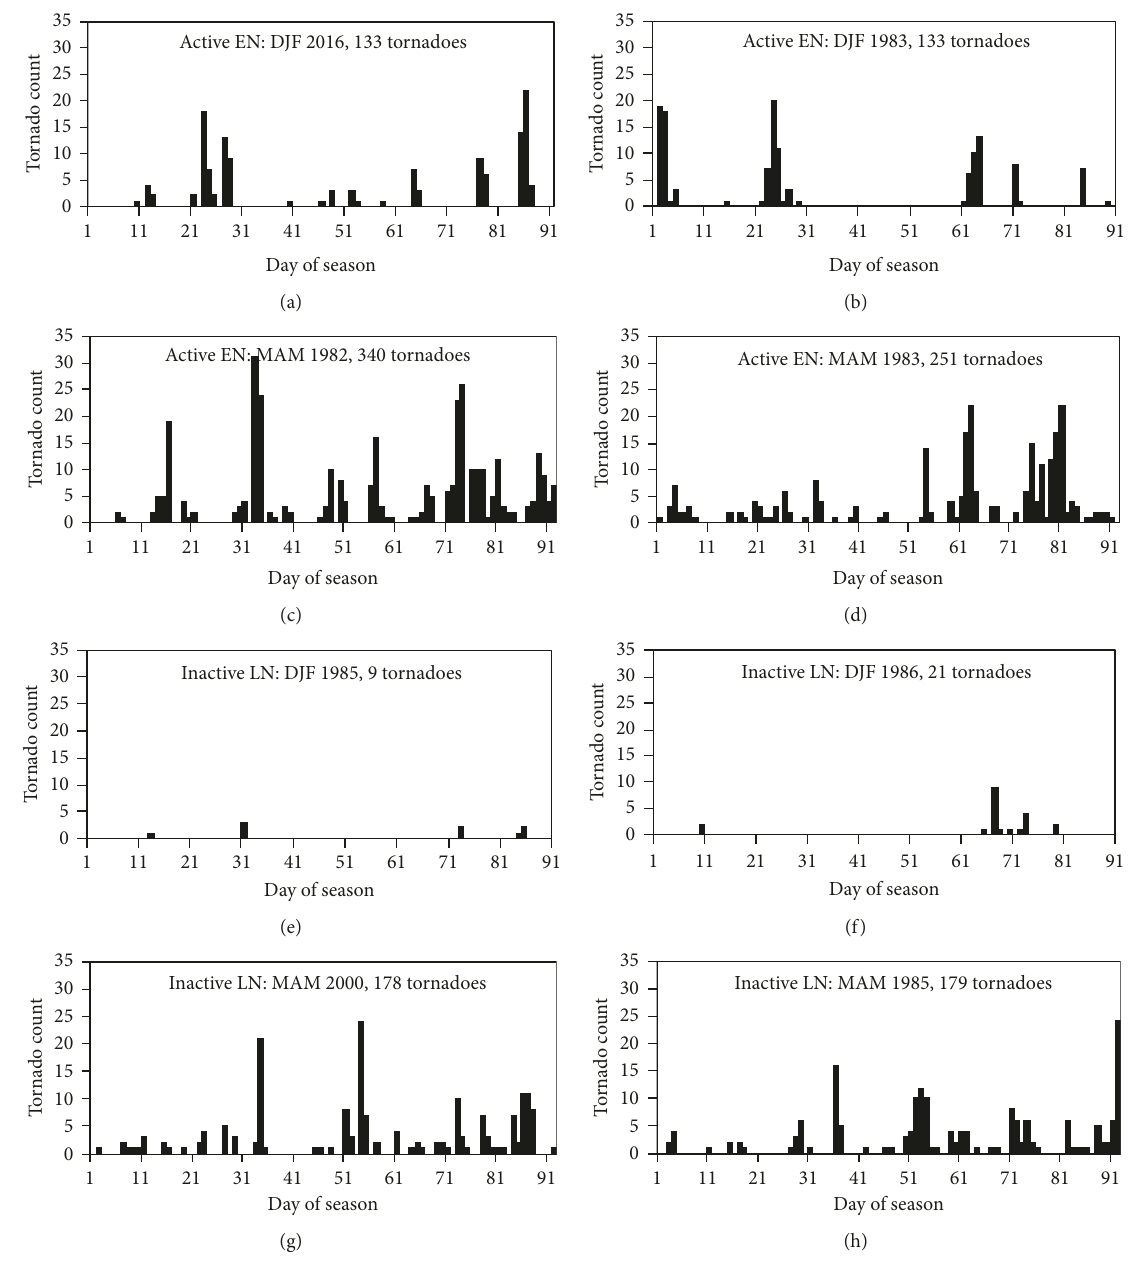
Figure 2: Daily tornado count of the two EN DJFs (a, b) and MAMs (c, d) with the most tornadoes and of the two LN DJFs (e, f) and MAMs (g, h) with the fewest